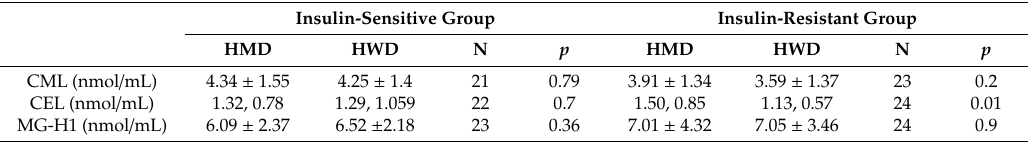
Table 3. Advanced glycation end product levels in diets separately analysed by insulin sensitive / resistant